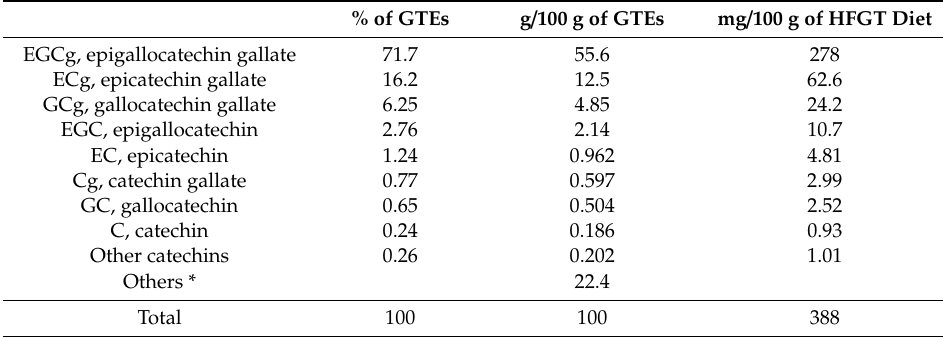
Table 2. Catechins content of GTEs and HFGT